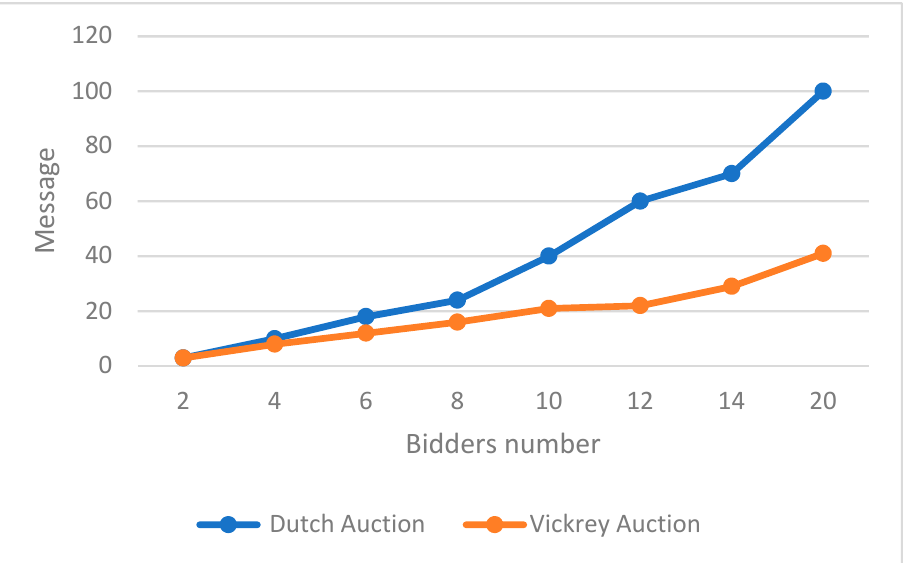
Figure 6. Messages required to complete an auction as the number of bidders grows in a demand- driven scenario.